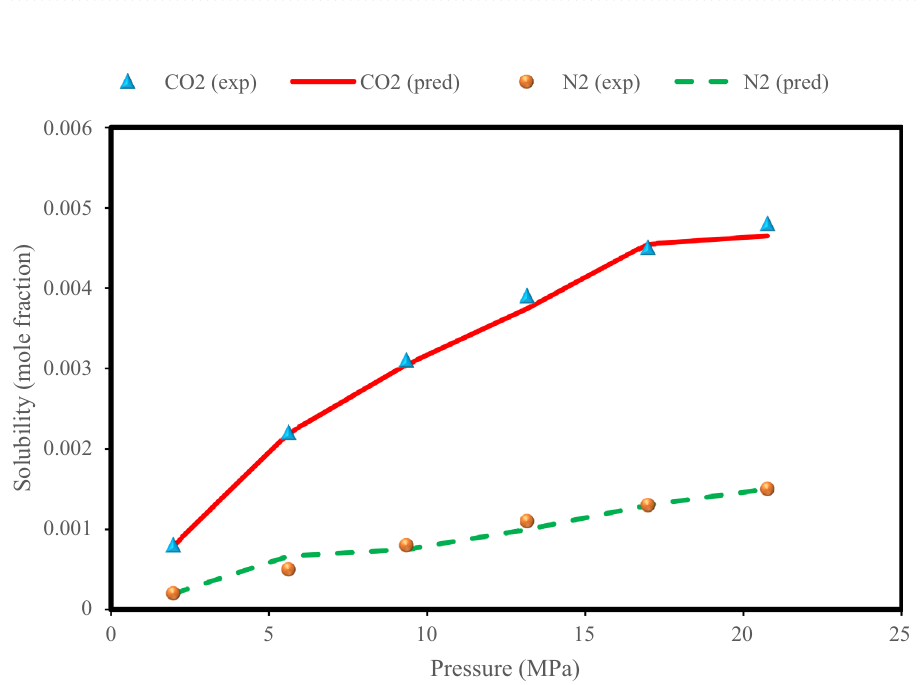
Figure 9. Experimental values 10 of CO 2 and N 2 solubilities in the N 2 (85.4%) + CO 2 (14.6%) + H 2 O system at a temperature of 303 K with predictions of the Random Forest